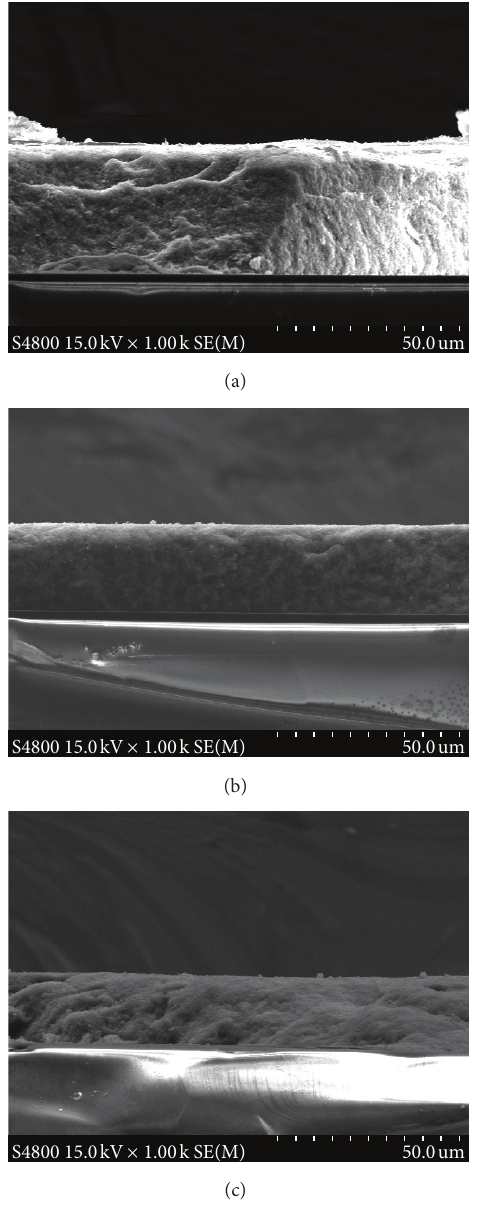
Figure 2: FE-SEM image of thin film thicknesses at (a) 35.66 𝜇 m, (b) 24.40 𝜇 m, and (c) 18.58 𝜇 m.